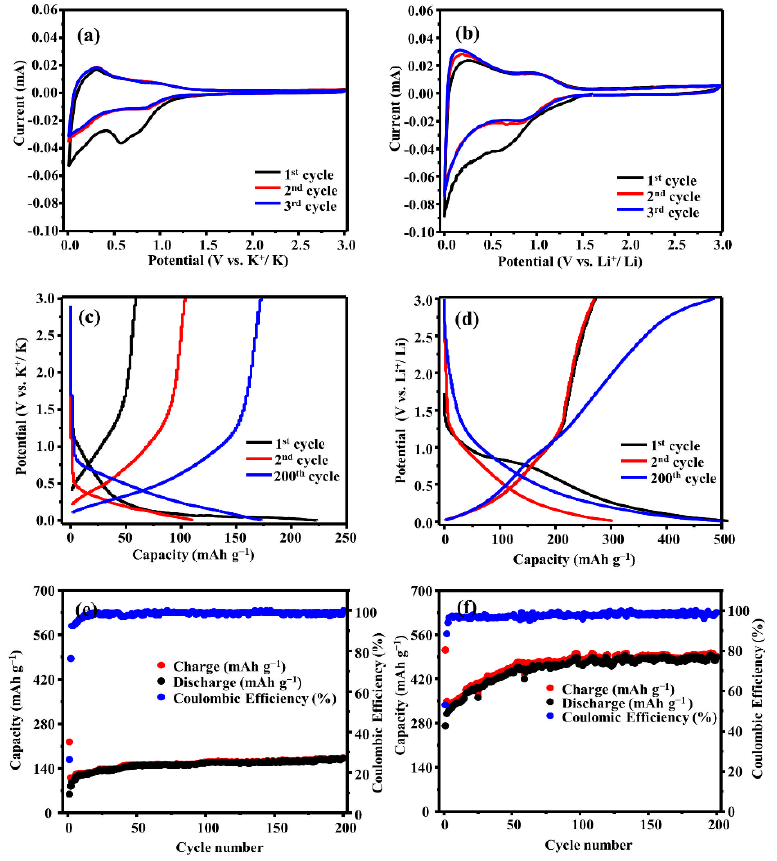
Figure 3. ( a , b ) CV curves, ( c , d ) galvanostatic charge/discharge curves, and ( e , f ) cycling behavior ( a , c , e ) K − MA_KFSI and ( b , d , f ) K − MA_LiFSI. Desai et al. reported that the energy density of an organic anode can be increased by operating it at a lower voltage [24]. Al though K-MA_KFSI began its charging process near